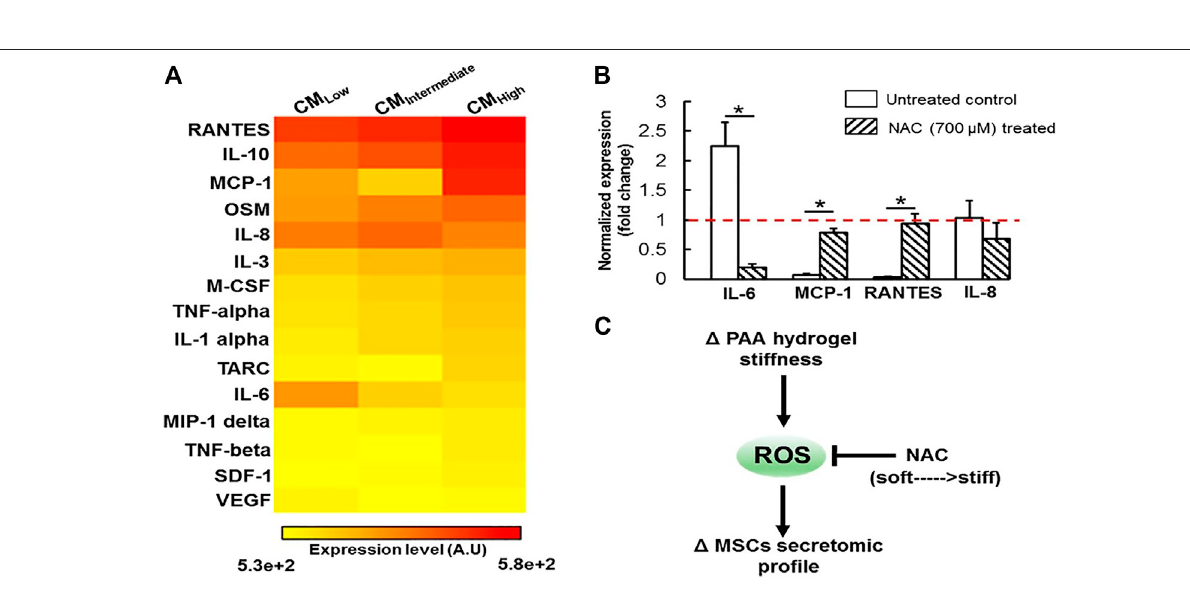
FIGURE5| SubstratestiffnessmodulatesMSCssecretomiclandscapeviaaROSdependentmechanism. (A) Heatmap analysisof15secretedproteinsbyMSCs revealedsubstratestiffnessisapotentregulatorofMSCssecretome. (B) TheimpactofNACtreatmentonexpressionofseveralmechanosensitivesecretedproteinswas assessed at the transcript level, which is normalized tothe level of the housekeeping 18s gene (dashed horizontal line). NAC treatment signi fi cantly altered expression of IL-6, MCP-1 and RANTES in a manner that is similar to culturing the cells on substrate with different stiffness, suggesting that ROS may play an important role in mediating the substrate stiffness effect. All data are presented as mean ± SD ( n = 5) * denotes statistical difference at p < 0.05. (C) Schematic diagram depicting the proposed mechanism by which substrate stiffness can alter MSCs secretome in a ROS-dependent manner. Reprinted (adapted) with permission from (Yang et al., 2016). Copyright (2016 – 2021) American Chemical